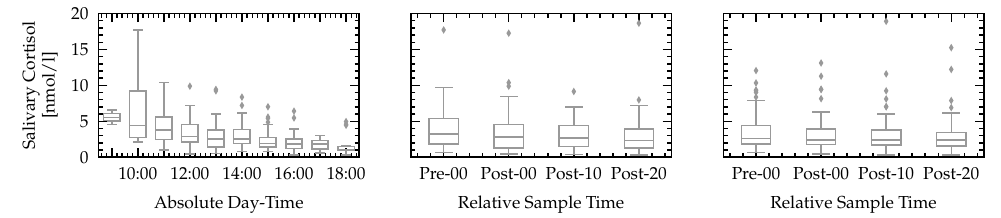
Figure 12. The start of each experiment was executed with a given daytime schedule described in Section 2.5. Some subjects required more time for task comprehension or were repeating the training phase multiple times. This leads to different absolute day-times of cortisol measurements while complying with the relative schedule described in Section 2.5. The first plot shows all measured cortisol values, throughout the day (accumulated one hour intervals). The second plot visualizes the cortisol values for the n -back experiment, while the last plot shows the results for k